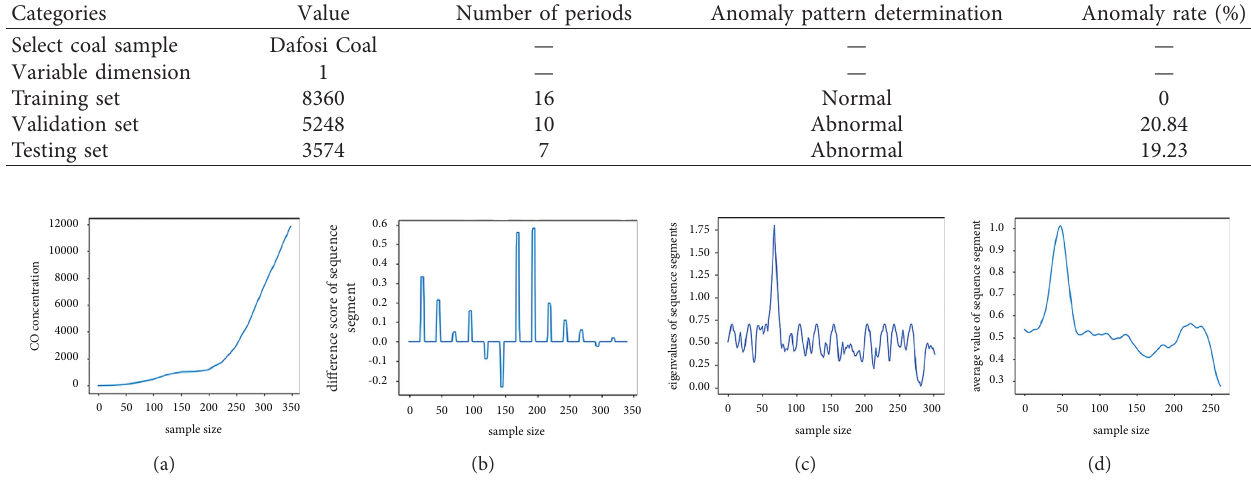
Figure 6: Series difference result